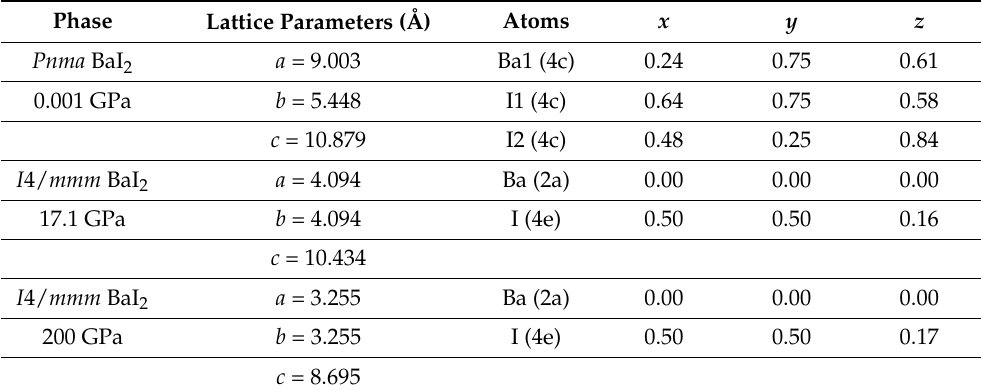
Table 1. Lattice parameters and atomic coordinates of BaI 2 . Phase Lattice Parameters (Å)